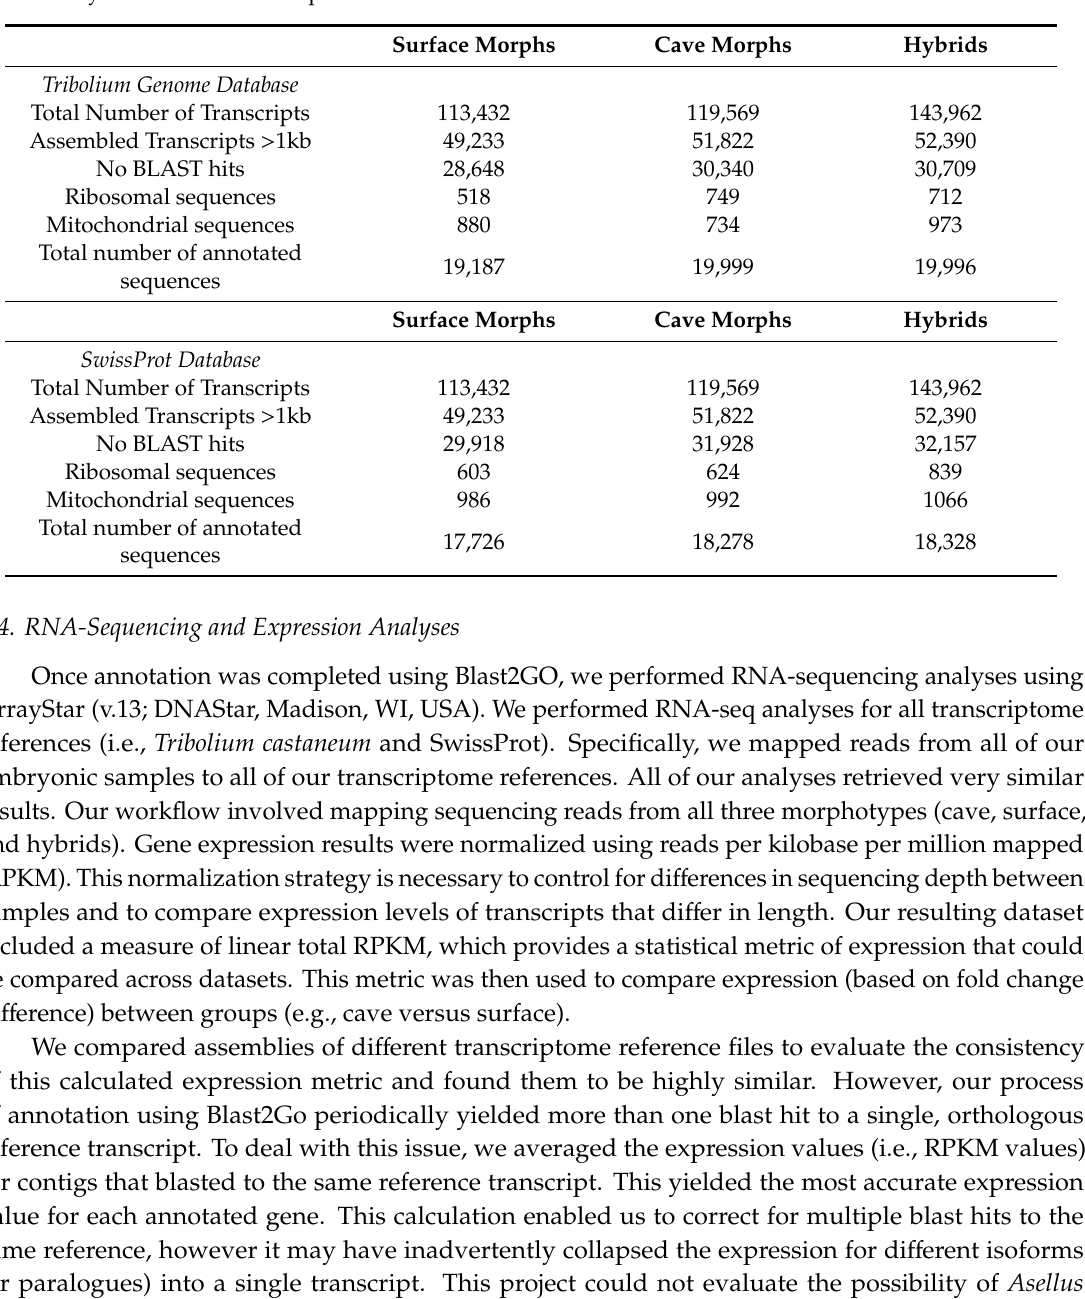
Table 2. Annotation results against two reference databases for Asellus cave morphs, surface morphs and hybrid de novo